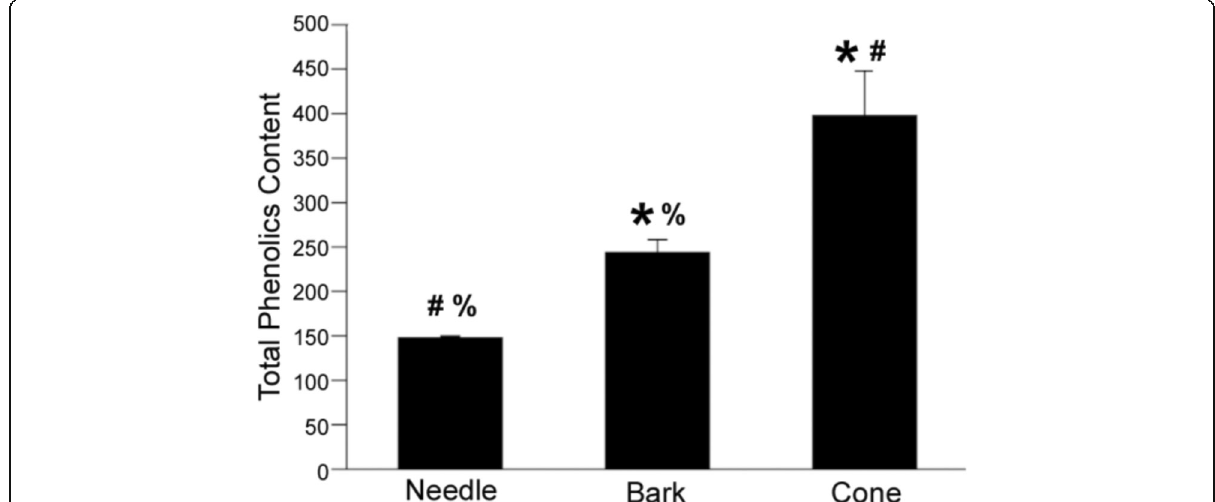
Fig. 4 Total phenolic content in terms of quercetin equivalents, of P. mariana needle, bark and cone extracts. Needle, bark and cone phenolic content was found to be significantly different from each other at p ≤ 0.05 (( * ) = significantly different from needle; ( # ) = significantly different from bark; ( % ) = significantly different from cone). Cone had the highest phenolic content with 398.68 (SE = 48.77, n = 5), followed by bark at 244.08 (SE = 14.51, n = 18) and needle with 146.34 μ g/mg extract (SE = 3.78, n = 40)